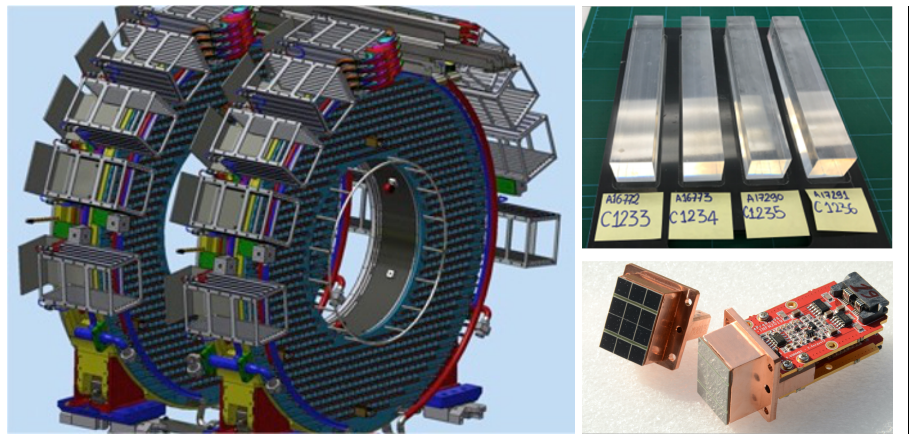
Figure 2. ( Left ), CAD of the two calorimeter disks. ( Top right ), few unwrapped calorimeter crystals with their own parallelepiped shape, and ( bottom right ), two SiPM arrays glued onto copper holder on the left and one readout unit formed by two SiPM arrays and two FEE boards mounted on its copper holder and on the